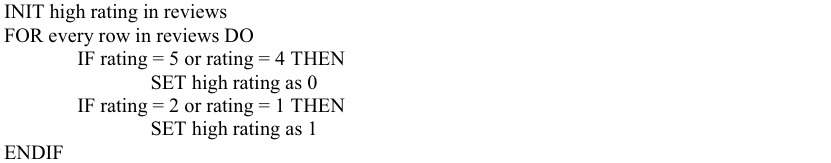
Table 2 Pseudocode to creates a binary classification INIT high rating in reviews FOR every row in reviews DO